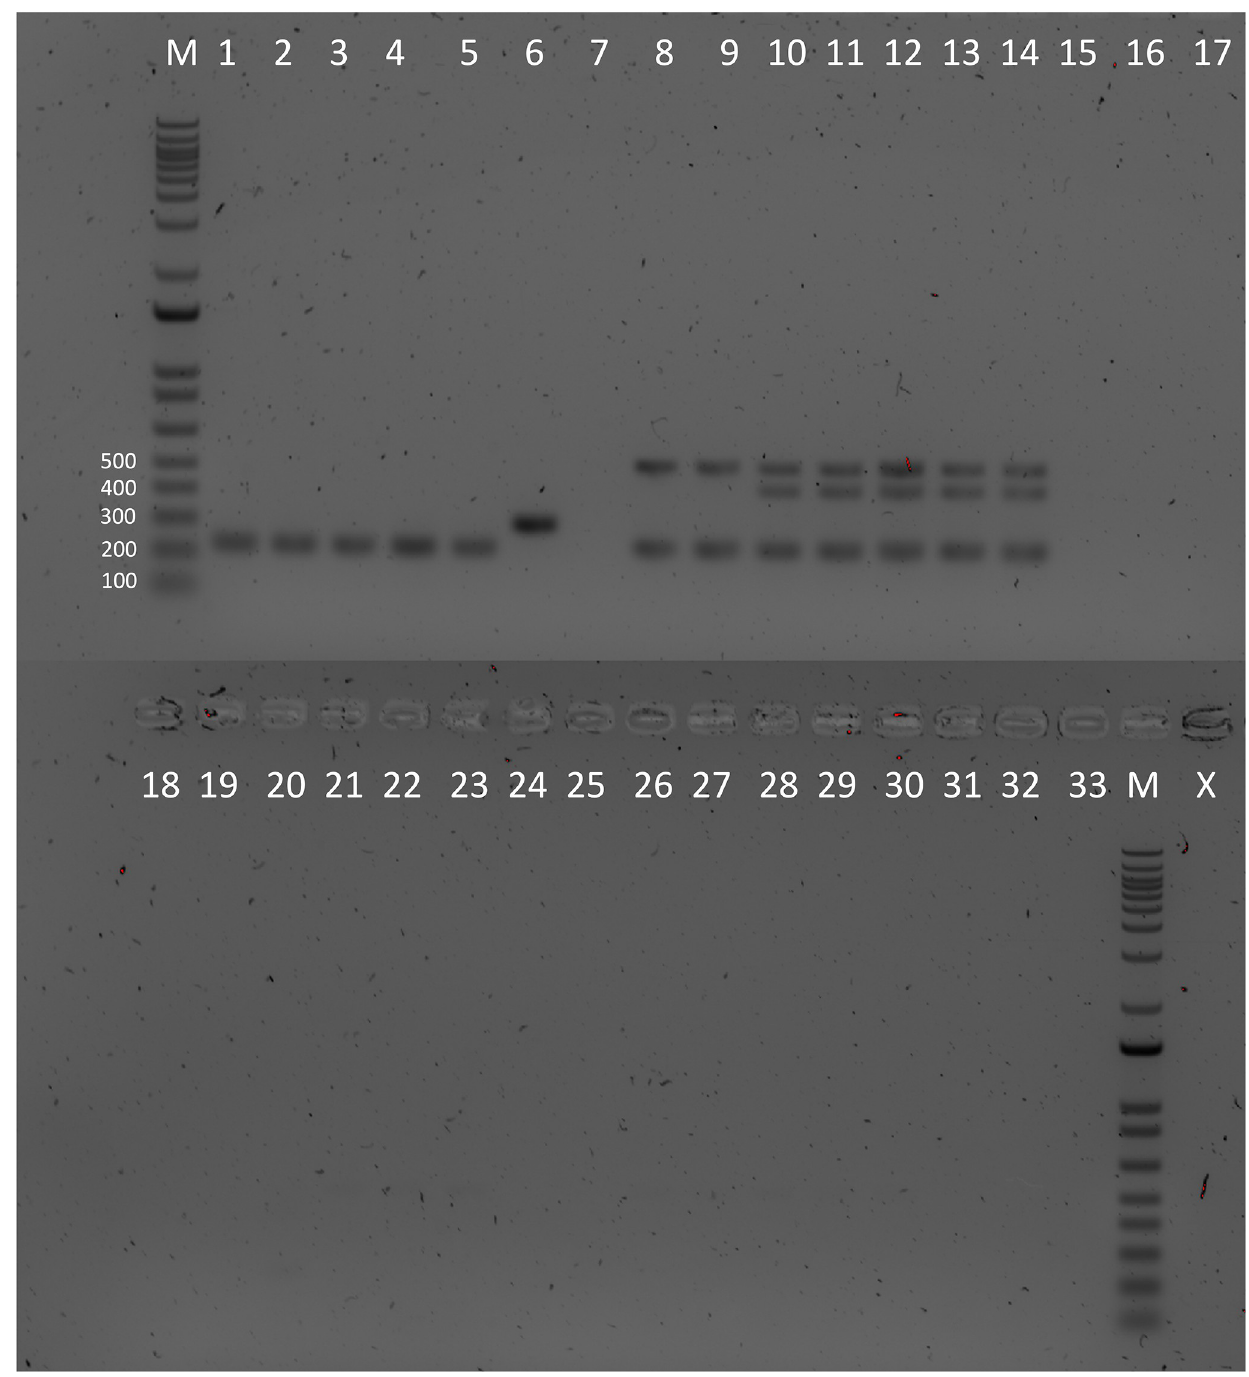
Fig 2. Pairwise alignment of the CT18 reference genome against an H58 (A) and XDR (B) genome showing the nucleotide position along the top and SNPs identified for our custom primer design highlighted underneath. The SNP of interest is highlighted in green in the H58 and XDR primer sequences, with the additional added mutation highlighted in yellow. The addition of a second mutation induced the specificity of the primers to bind to only our target. Sequences are shown in 5’-3’ direction unless otherwise indicated. Alignments produced and visualised using Geneious Prime v2021.1.1.